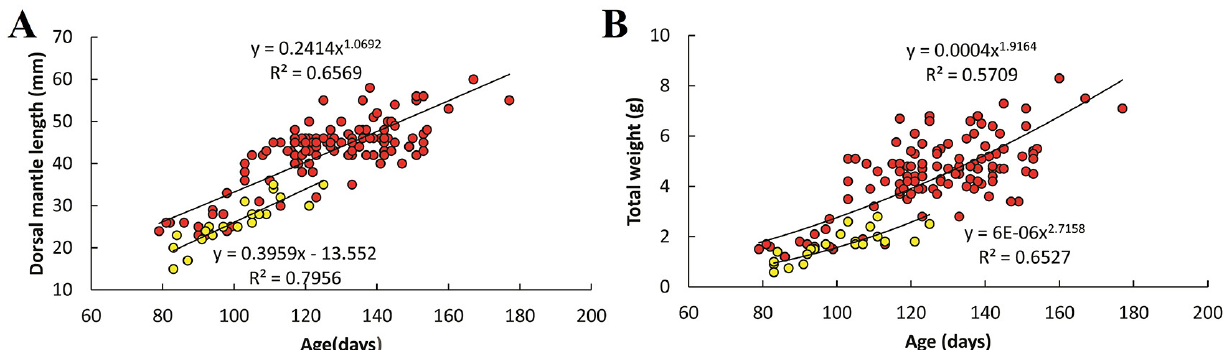
Fig.4. – Relationship between age with dorsal mantle length (A) and total weight (B) of males (yellow circles) and females (red circles) Abralia andamanica from the Arabian